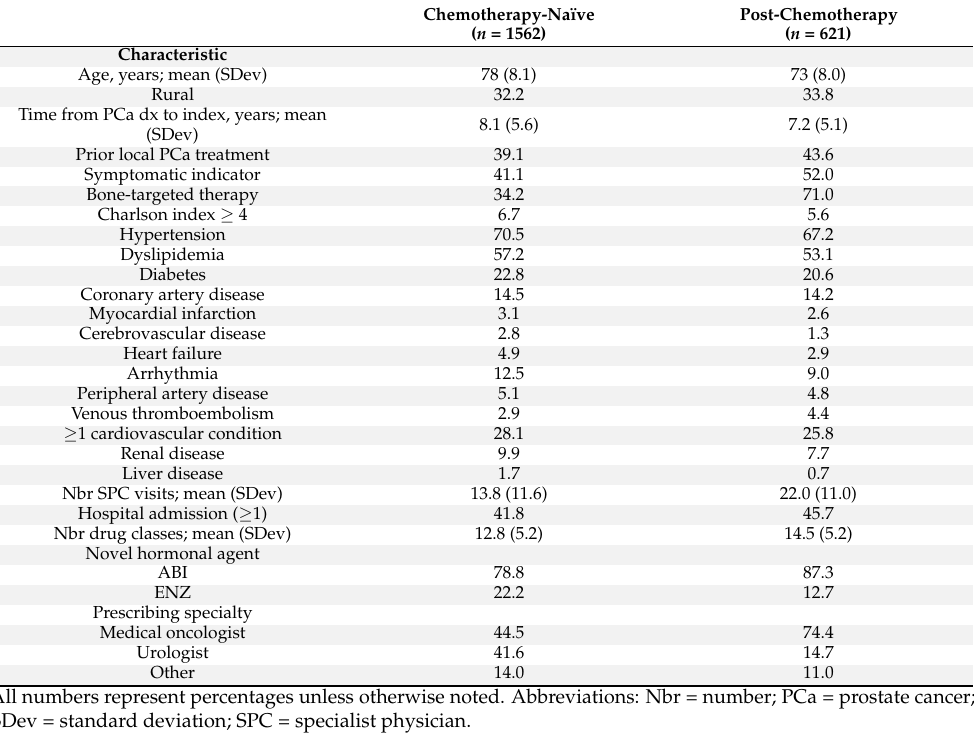
Table 1. Baseline characteristics.